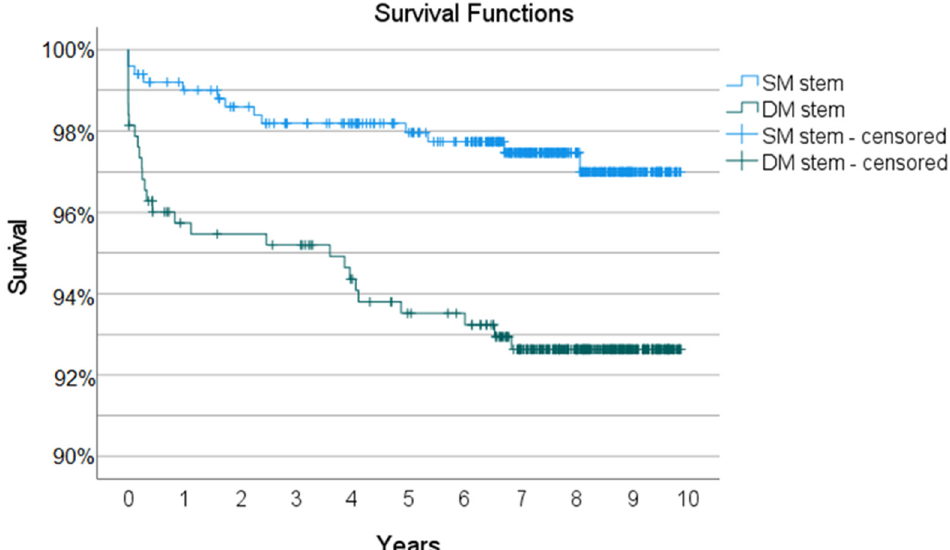
Figure 3. Kaplan-Meier survival curves with 95% confidence interval. DM–dual-modular stem, Figure 3. Kaplan ‐ Meier survival curves with 95% confidence interval. DM–dual ‐ modular stem, SM– SM–single-modular single ‐ modular stem.